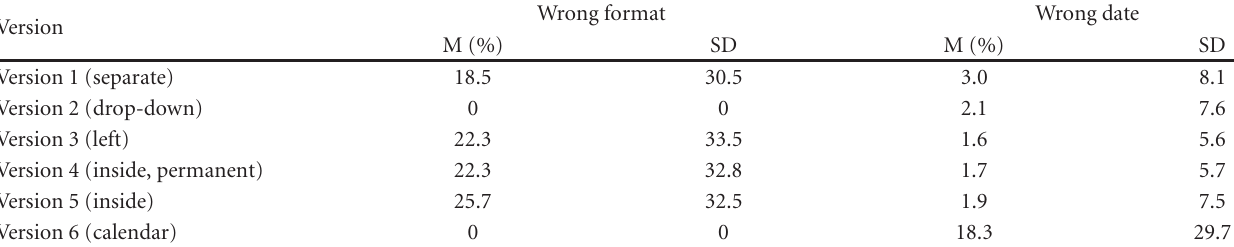
Table 1: Statistic parameters for number of errors: entries in a wrong format and wrong date.